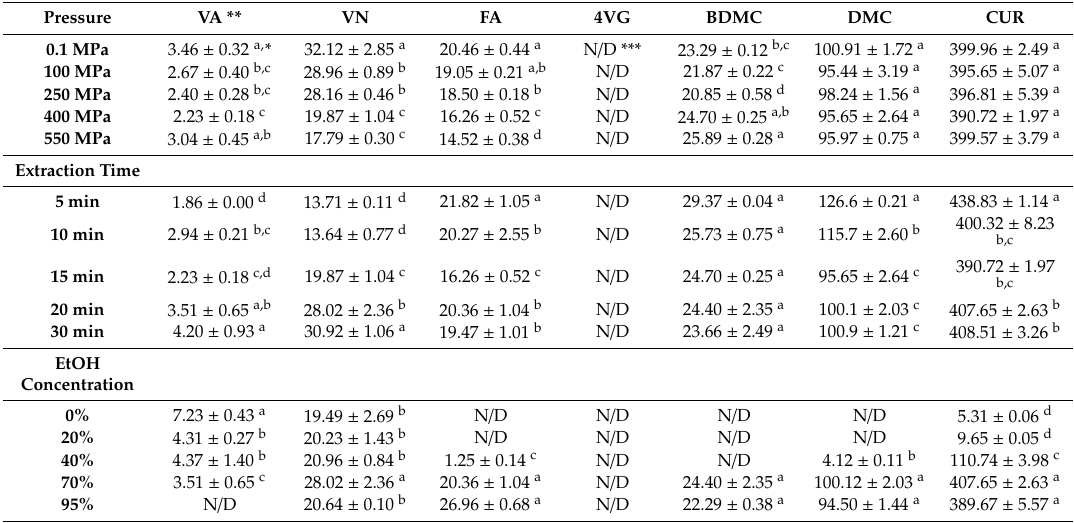
Table 2. E ff ects of pressure, extraction time, and ethanol concentration on bioactive compounds ( µ g / g dried turmeric) in the HHPE turmeric analyzed by